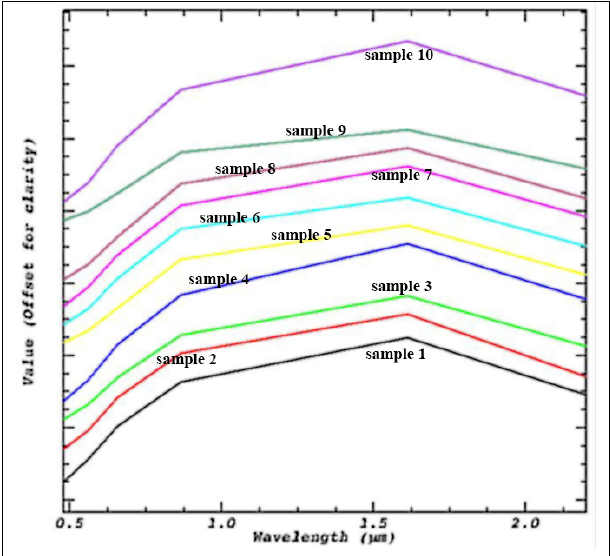
Figure 5. Z-Profile related to the locations of sampling obtained from OLI